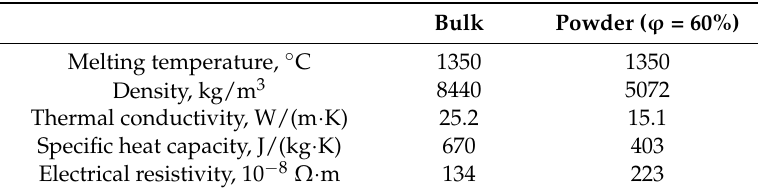
Table 1. Physical properties of IN625 powder